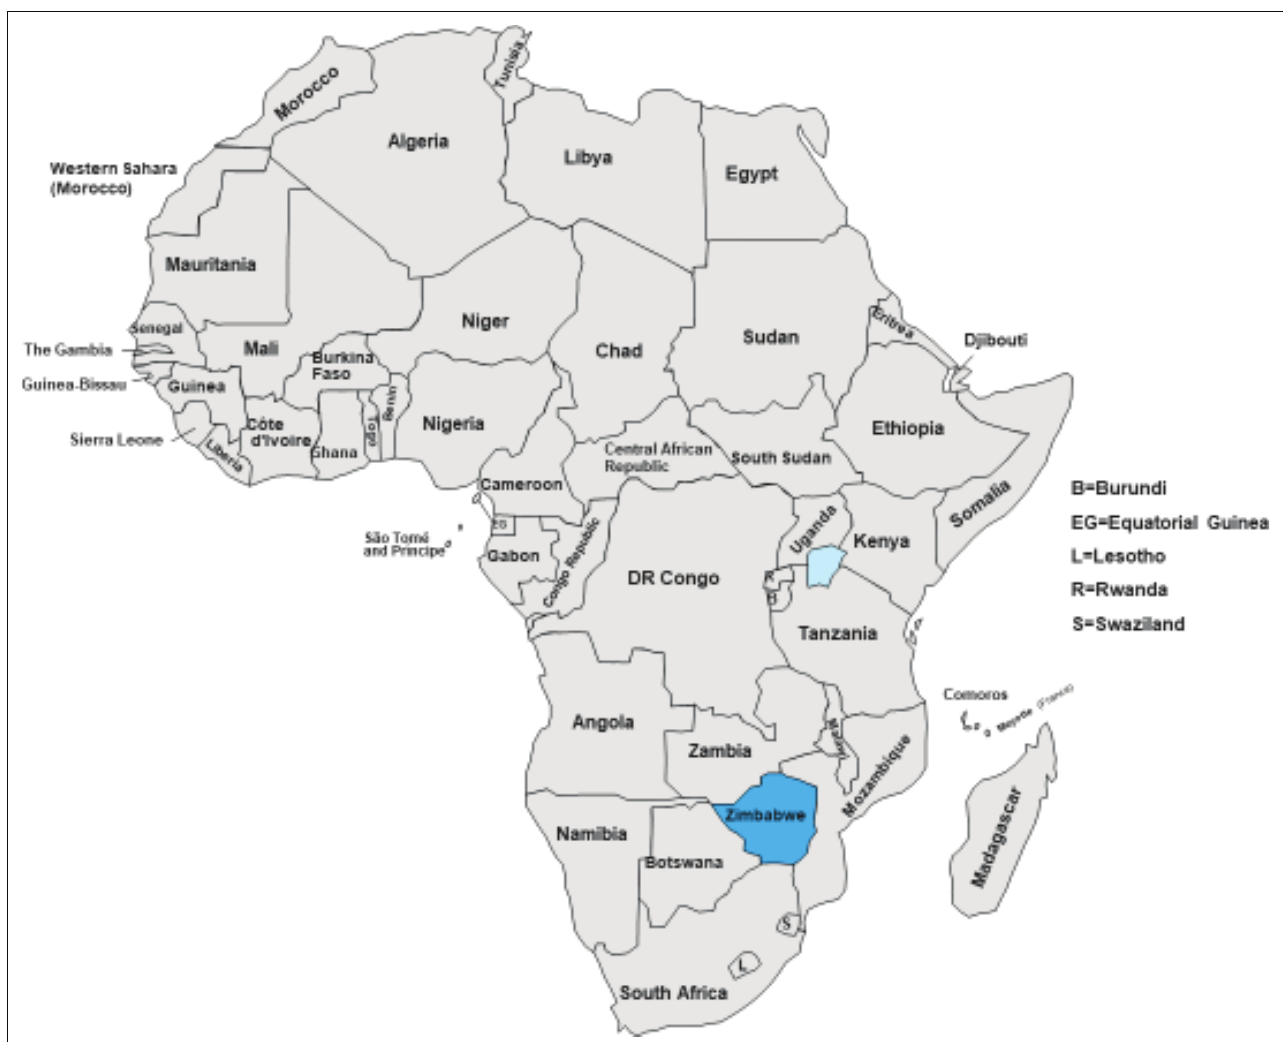
FIGURE 1: Africa with Zimbabwe landlocked in the Southern African